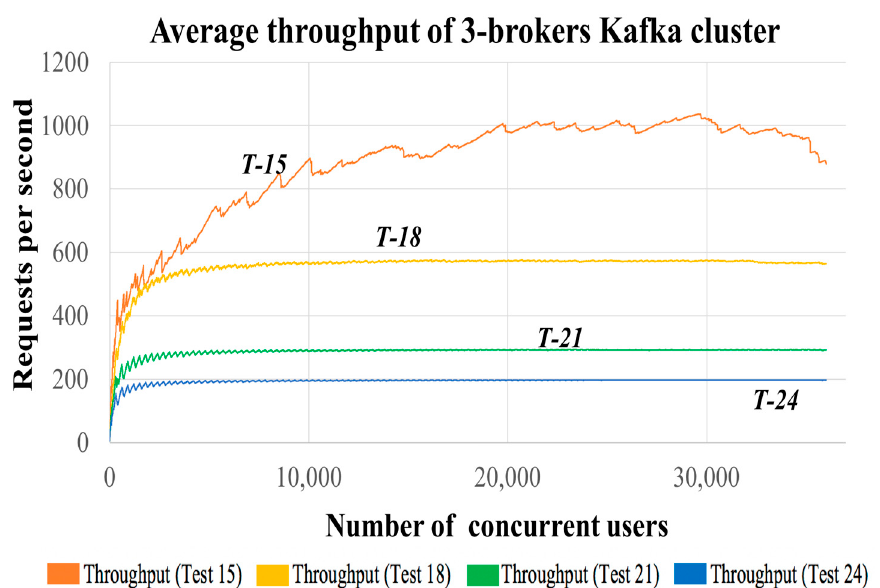
Figure 18. Average throughput of a 3-broker Kafka cluster subjected to a workload of 36,000 requests for 1 s (Test 15), 60 s (Test 18), 120 s (Test 21), and 180 s (Test 24).